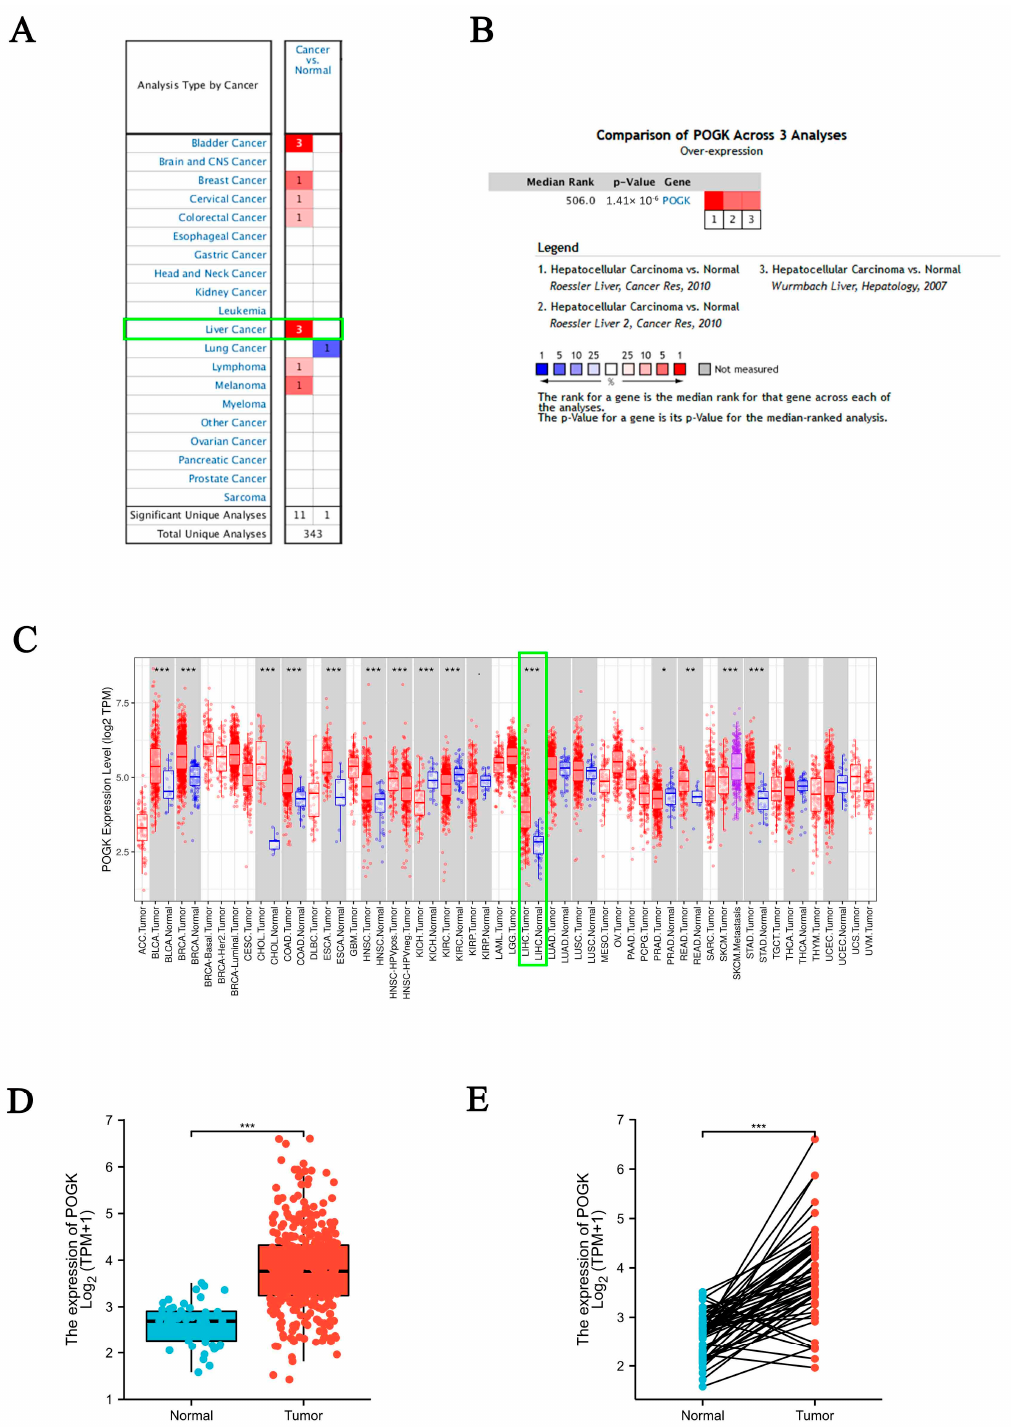
Figure 1. POGK expression analysis by Oncomine, TIMER, and TCGA databases. ( A ) POGK expression in different types of human cancers in Oncomine database, the numbers in the boxes represent the number of datasets, green box highlights hepatocellular carcinoma; ( B ) Upregulation (red) of POGK in hepatocellular carcinoma compared with normal tissue by Oncomine meta-analysis, the numbers in the boxes refer to the datasets below [13,14]; ( C ) POGK expression in different types of human cancers in TIMER database, green box highlights hepatocellular carcinoma; ( D ) Different POGK expression in normal and tumor tissues in TCGA database; ( E ) Different POGK expression in paired tissues in TCGA database. *: p < 0.05, **: p < 0.01, ***: p <